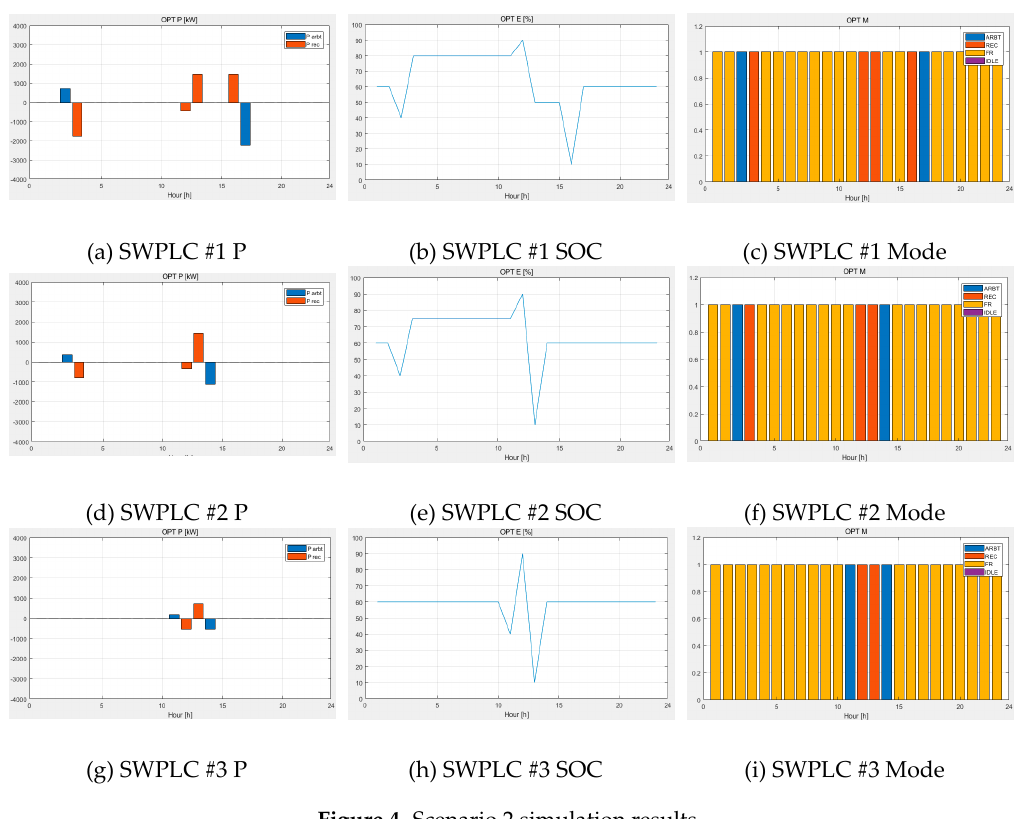
Figure 4. Scenario 2 simulation results.